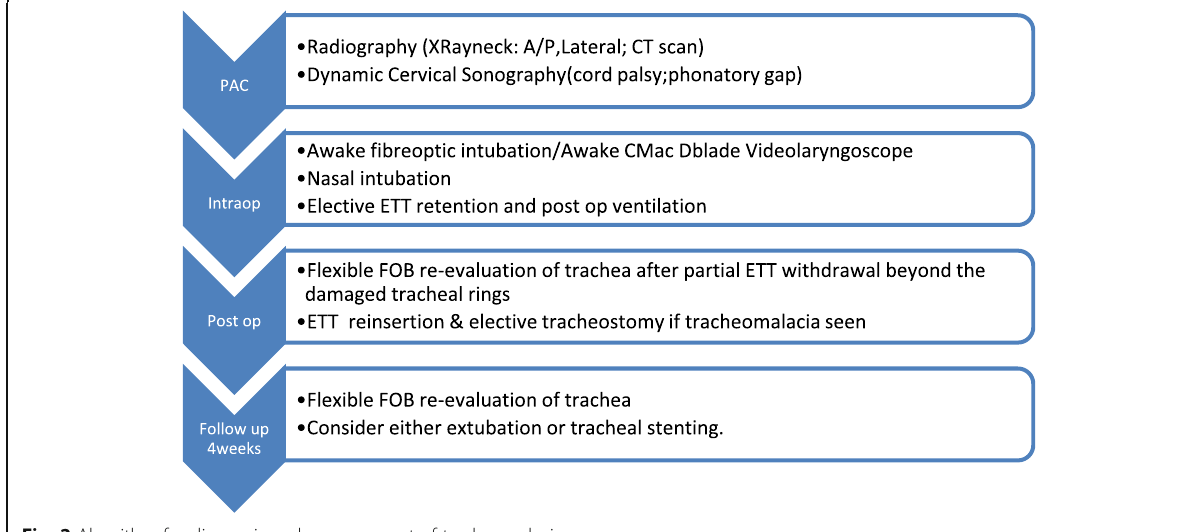
Fig. 2 Algorithm for diagnosis and management of